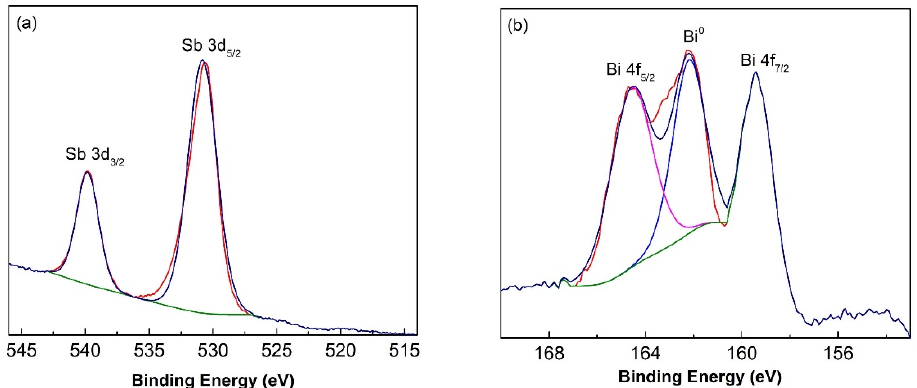
Figure 4. High resolution XPS spectra of antimony Sb 3d ( a ) and bismuth Bi 4f ( b ) for sintered sample with nominal Bi content, X Bi = 0.2.